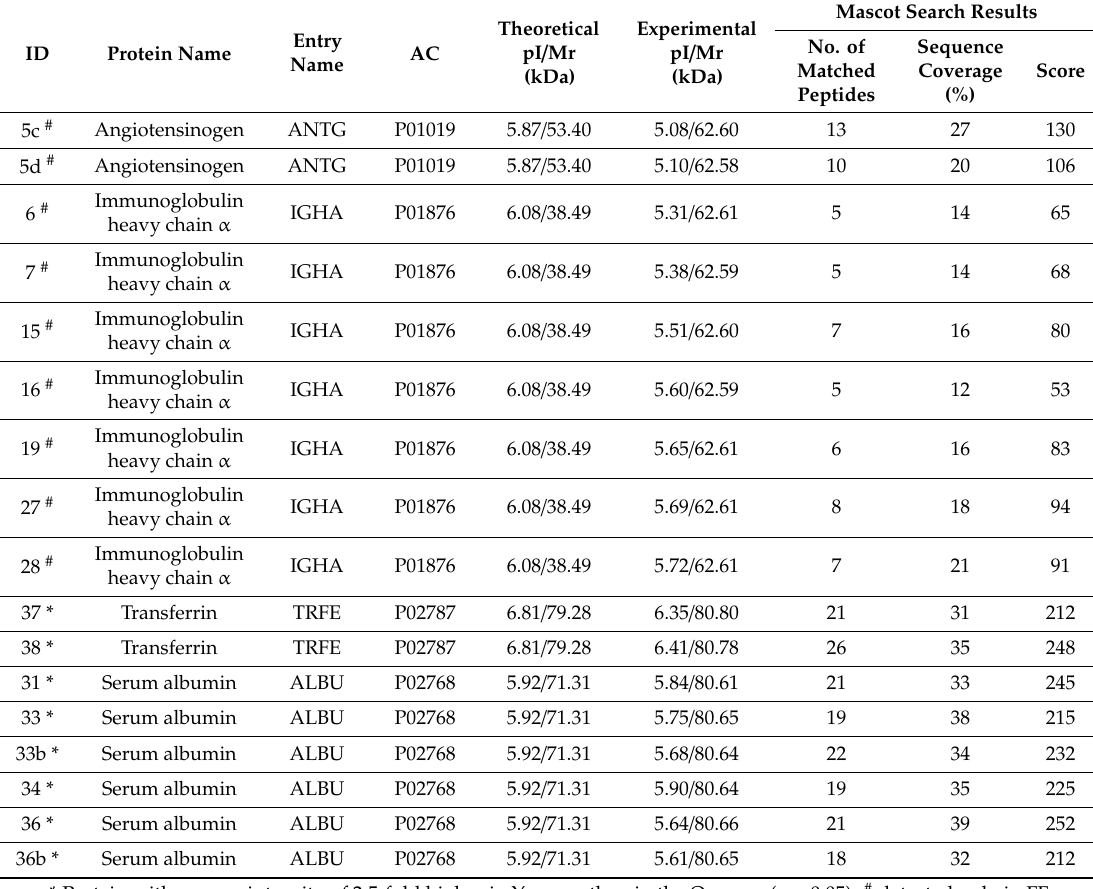
Table 1. List of proteins identified in follicular fluid di ff erently expressed in young patients than in old. The table reports the protein name, the accession number, theoretical and experimental pI and molecular weight (MW). Mascot Search Results comprehending number of matched peptides, sequence coverage and